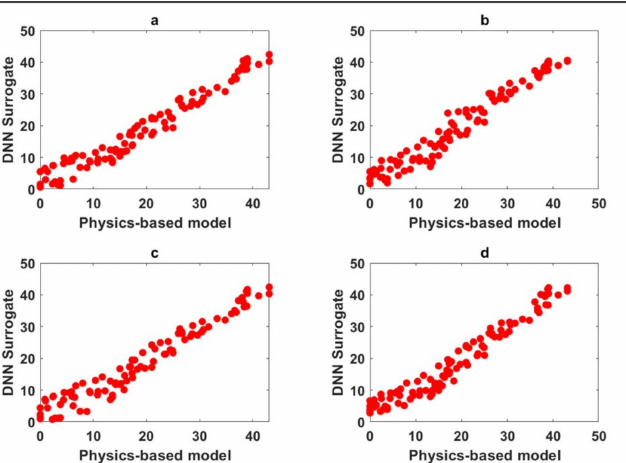
Figure 8. DNN surrogate model steady-state hydraulic head (in meters) prediction compared to the physics-based numerical groundwater model steady-state hydraulic head (in meters) estimates. Results from top-4 best performing models are in order of best metrics from ( a – d ).